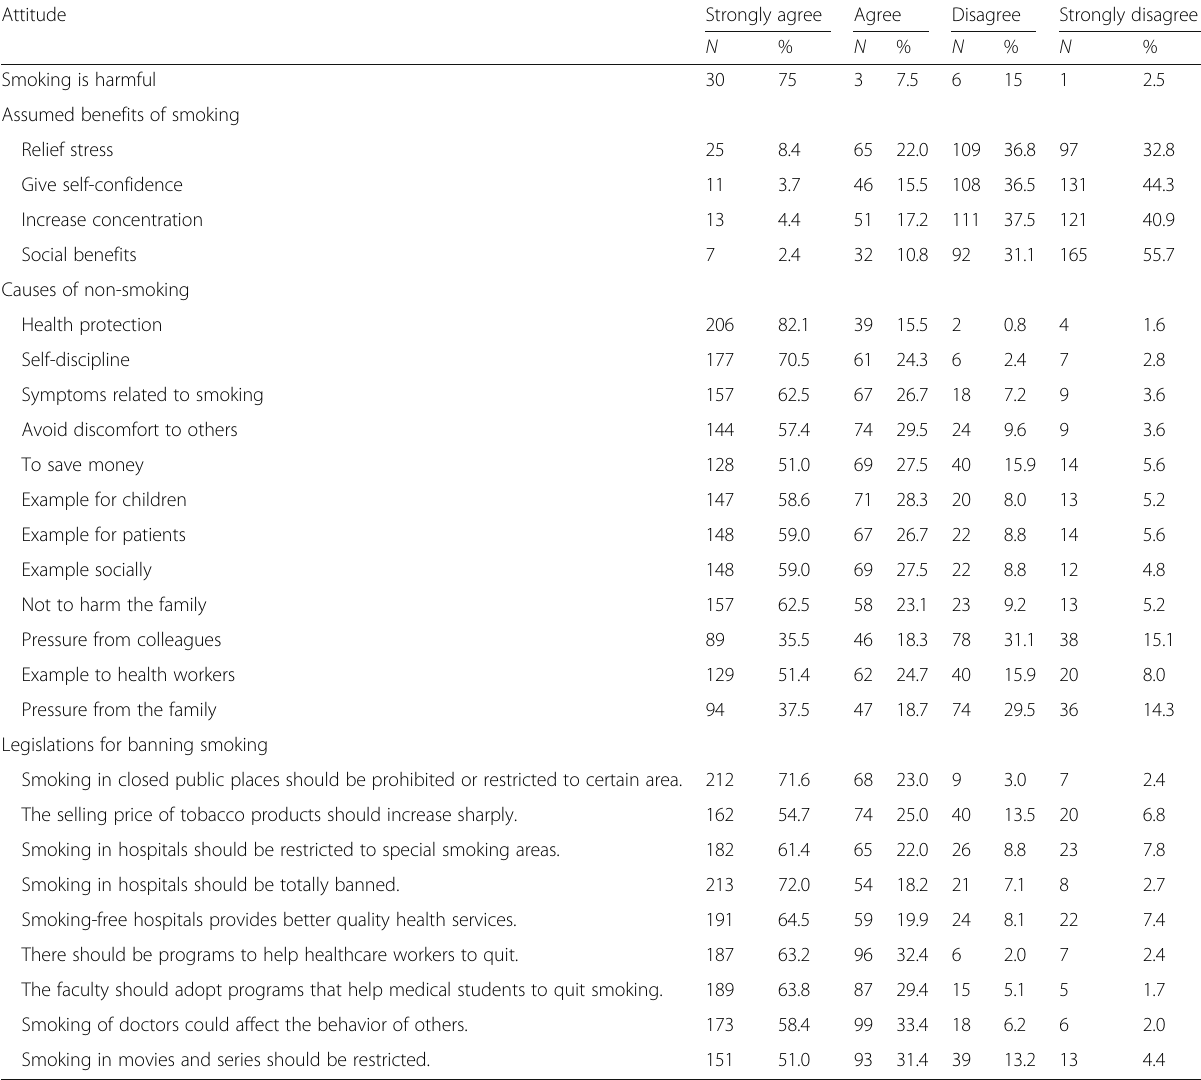
Table 2 Attitudes of students regarding the effect of smoking, causes of non-smoking, and legislations for banning it, Cairo